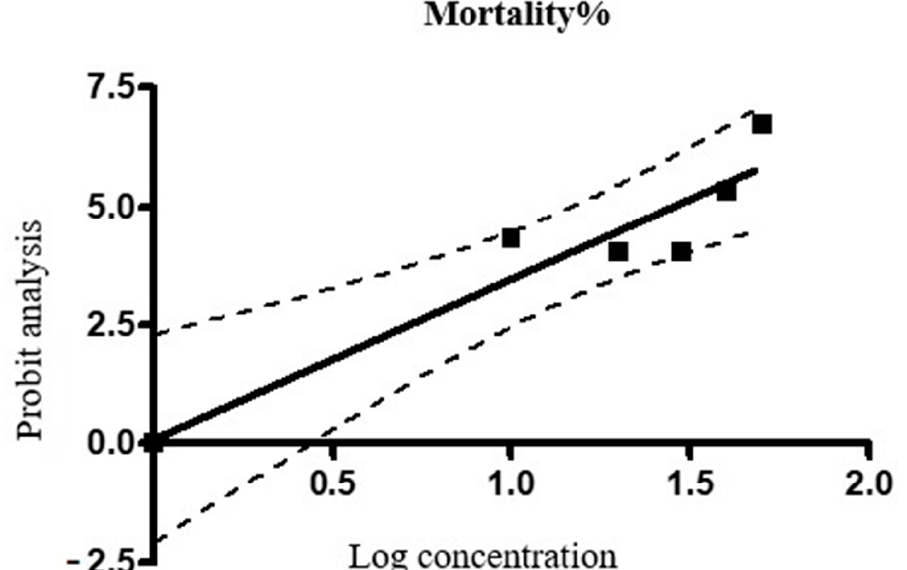
Figure 1. Dose-response curve of per cent adult tick